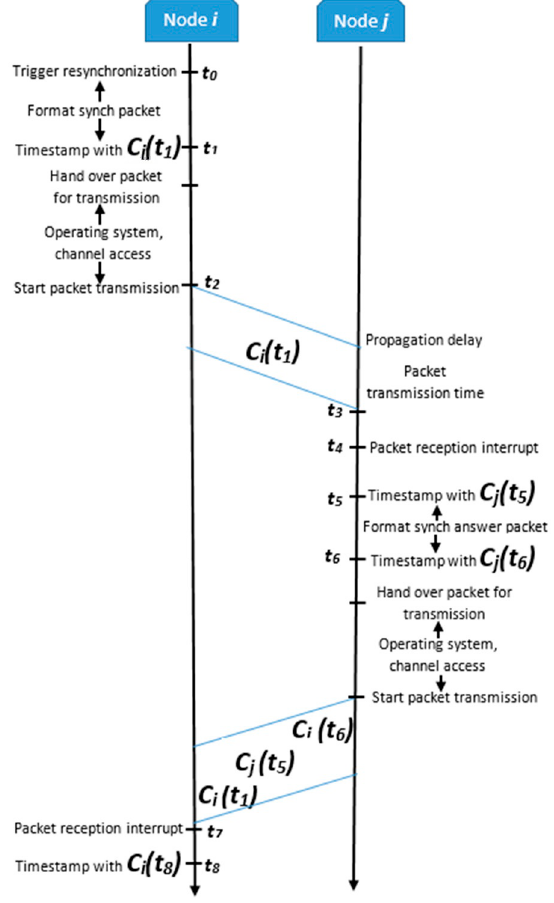
Figure 7. LTS pairwise synchronization.